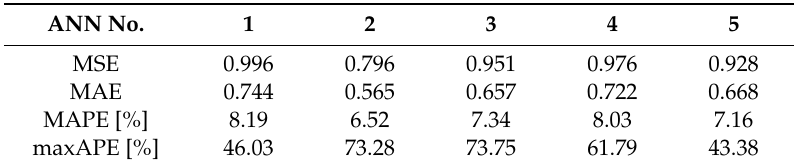
Table 5. The errors of predictions